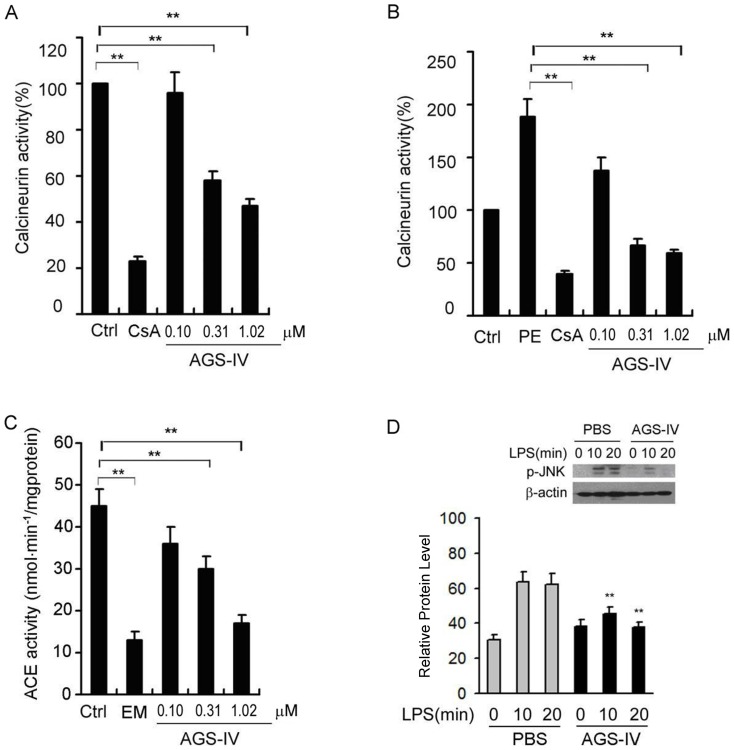
Evaluation of AGS-IV on representative protein targets.(A) Calcineurin activity in VSMCs following a 24-h pretreatment with AGS-IV (0.10∼1.02 µM), while cyclosporin A (CsA) was used as positive control. (B) PE-induced calcineurin activation in VSMCs following a 24-h pretreatment with AGS-IV (0.10∼1.02 µM). (C) ACE activity in HUVECs following a 20-min pretreatment AGS-IV (0.10∼1.02 µM), while enalapril maleate (EM) was used as positive control. (D) AGS-IV (1.02 µM) inhibited LPS-induced activation of JNK for at least 20 min. JNK phosphorylation levels were determined by Western blot, analyzed by Quantity One™ software (BioRad Inc.) and normalized to β-actin.